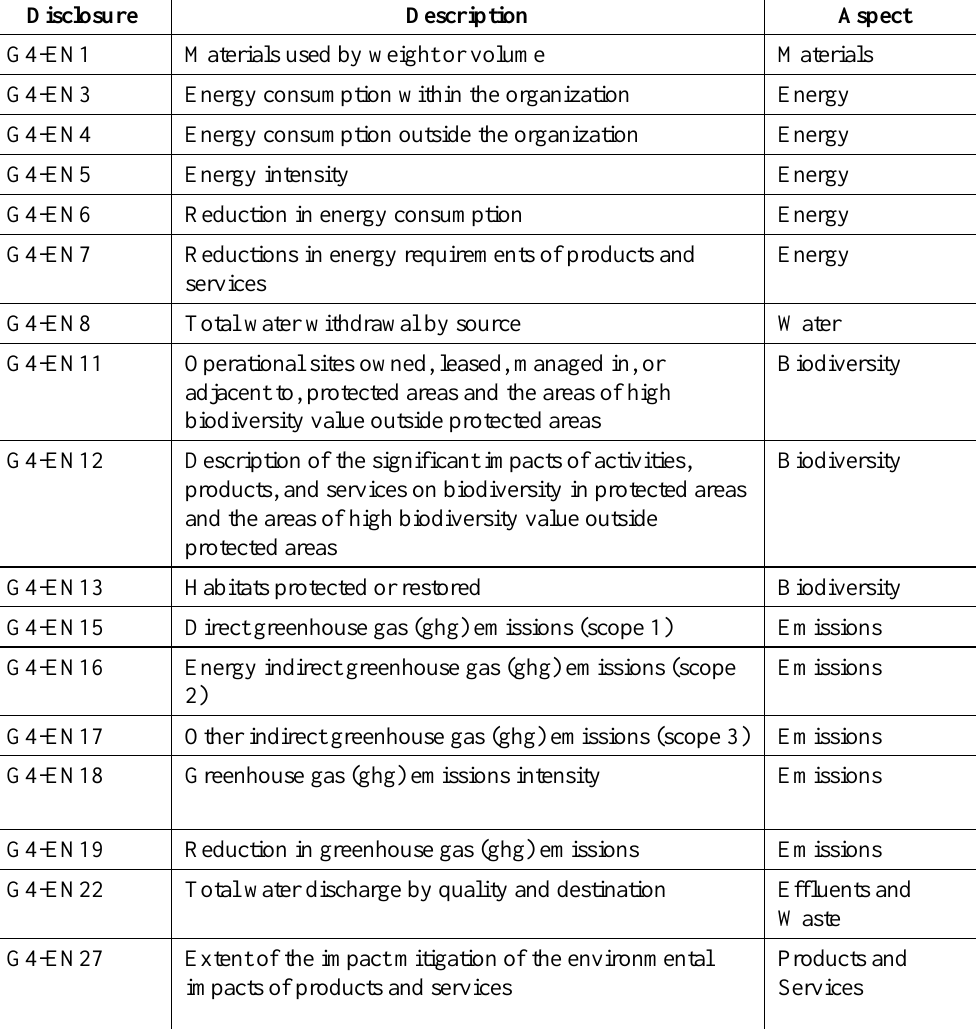
Table 3. Pro-environmental disclosures in GRI